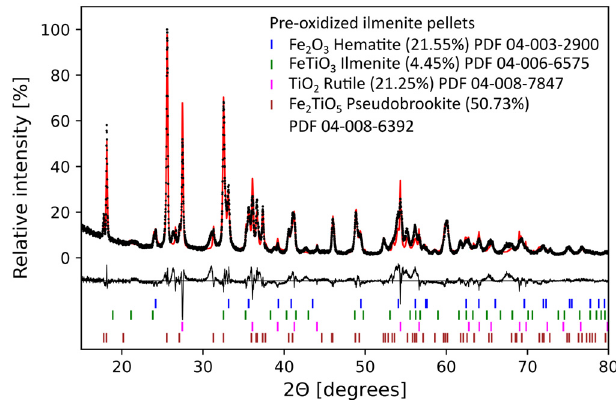
Figure 1. X-ray diffraction patterns for the pre-oxidized ilmenite pellets. The measured data are given as black dots and the fitted data are given as a red line. The difference between the fit and the measured pattern is plotted below the pattern. The estimate of each phase in wt.% based on Rietveld fitting is given in the legend, the balance being